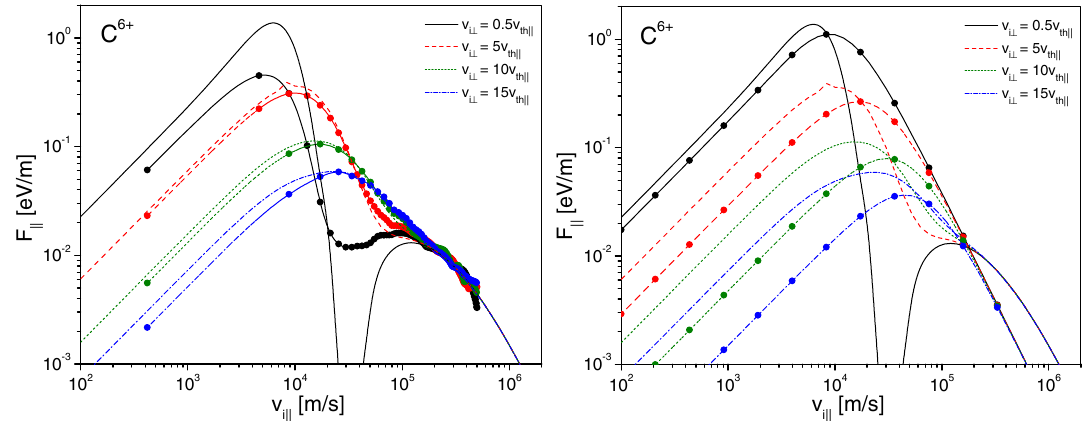
FIG. 4. Same as in Fig. 2 with v B ¼ 0 is increased by a factor 20.